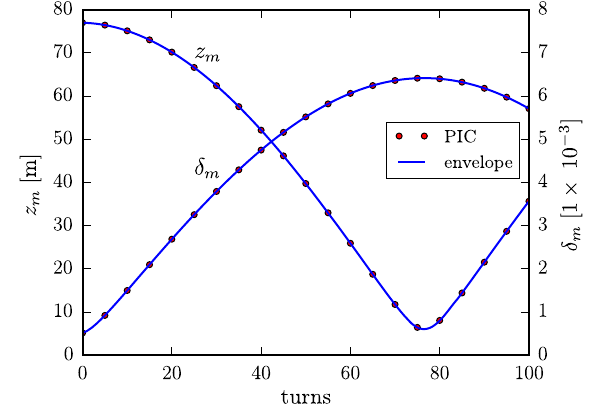
FIG. 4. Evolution of bunch length z spread δ during bunch compression obtained from PIC simu- m lation and envelope approach.